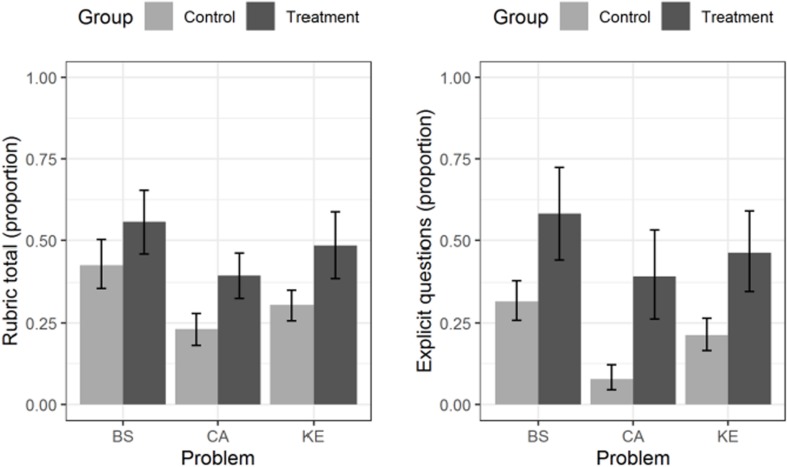
Left panel: Means (and their 95% CIs) for the total rubric score in each group, separately for each problem. BS = “Black Site”, CA = “Cyber Attack”, KE = “Kernel Error”. Right panel: Means (and their 95% CIs) for the explicit problem questions in each group, separately for the same three problems.